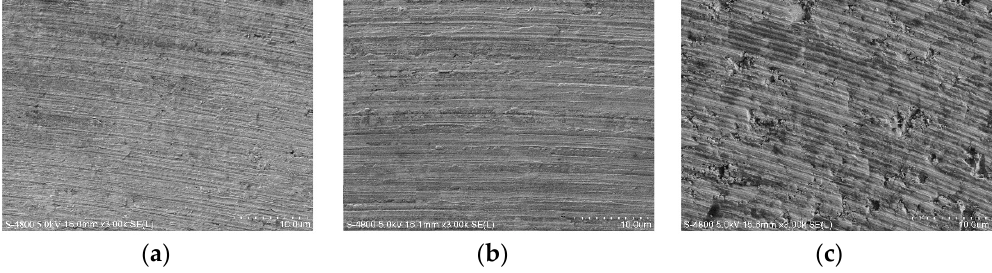
Figure 5. The machined surface morphology ( a p = 4 μ m). ( a ) f z = 0.3 μ m; ( b ) f z = 1.5 μ m; ( c ) f z = 2.7 μ m